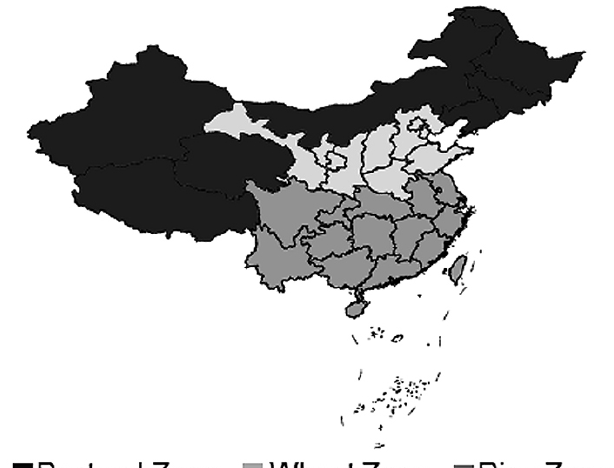
Fig. 2 . Pastoral zone and agricultural zone (wheat zone and rice zone) in